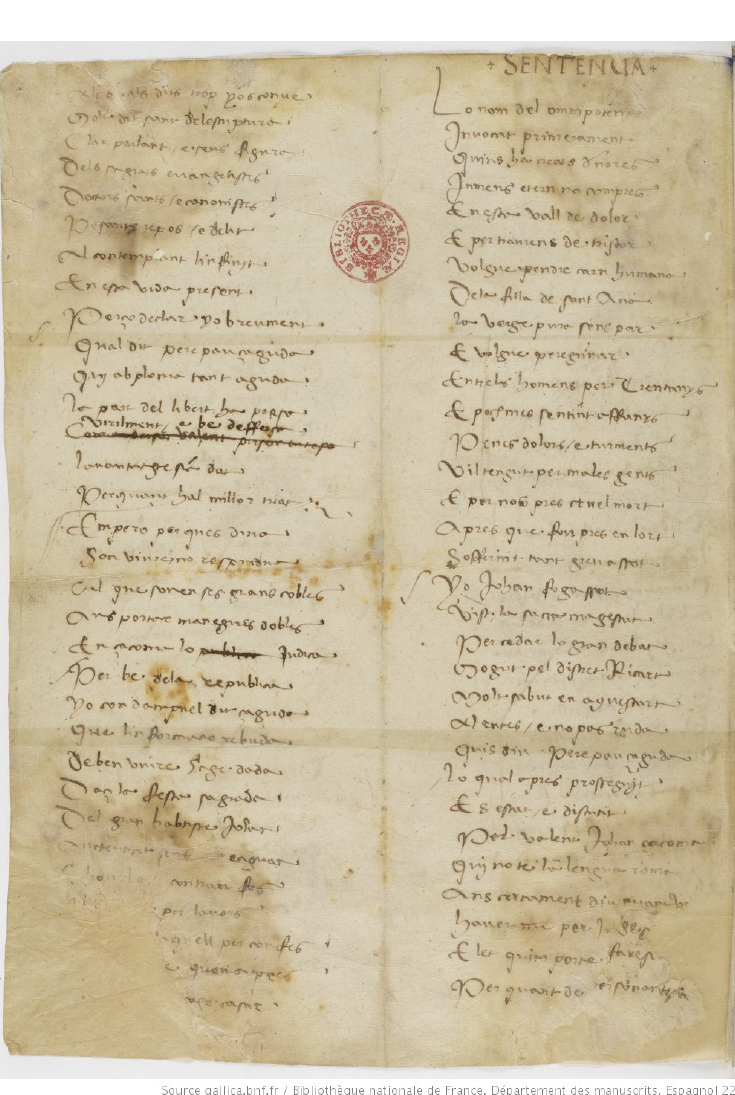
Fig. 1: París, Bibliothèque nationale de France, ms. espagnol 225, fol. ccxxxxvi verso. Font: gallica.bnf.fr / Bibliothèque nationale de